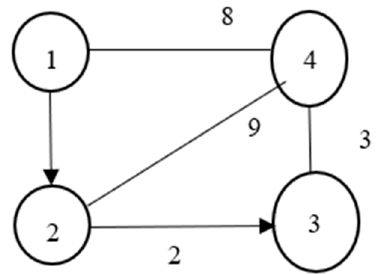
Figure 4. Semidirect graph of a road network system.